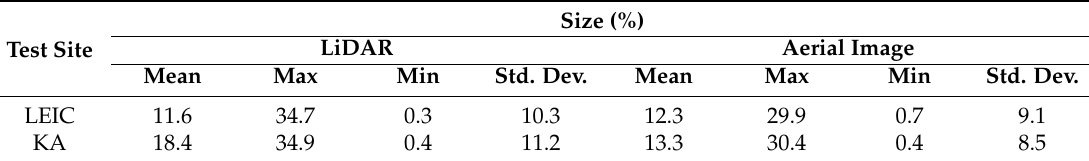
Table 7. Differences between the size of the extracted roof planes and their corresponding reference planes for both data types and test sites (Leicester = LEIC, Karlsruhe =